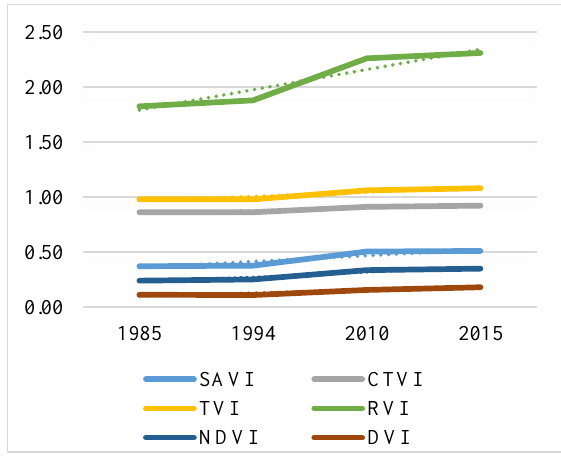
Figure 2. Curve of observed vegetation indices averaged in